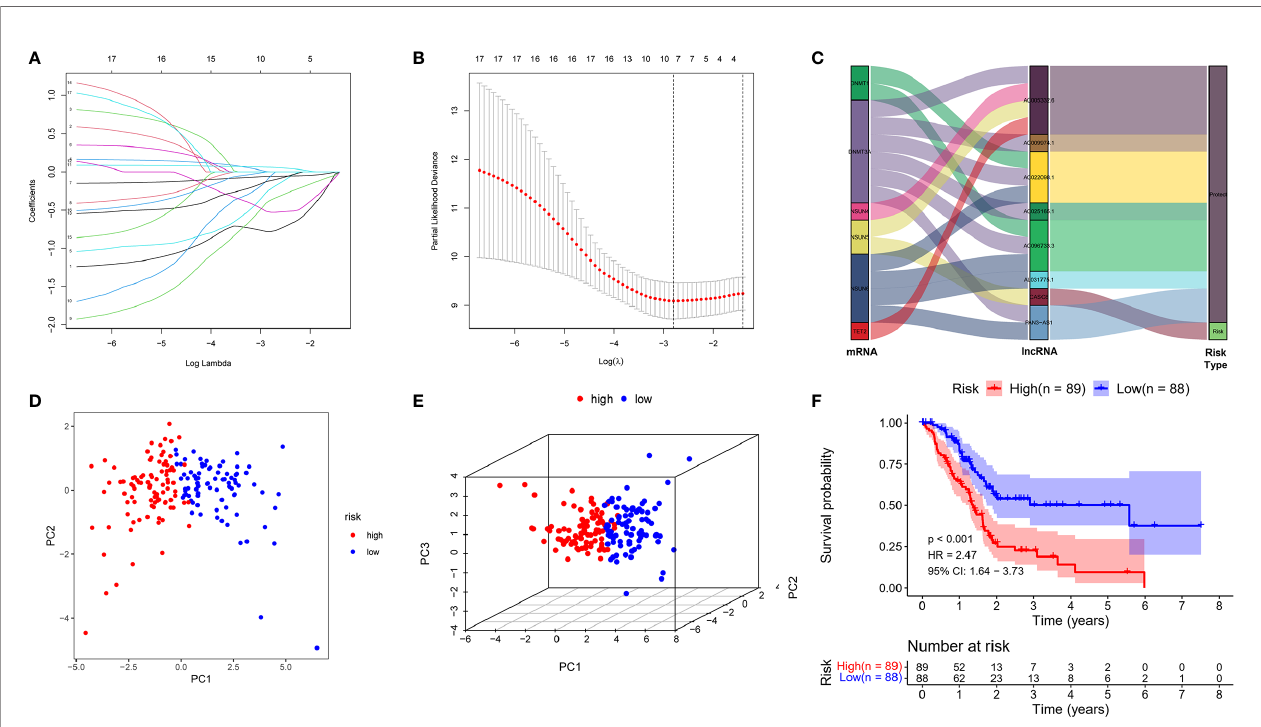
FIGURE 2 | Constructed a m5C-related lncRNA risk model in the PDAC cohort. (A) LASSO regression of the 17 m5C-related lncRNAs. (B) Cross-validation for optimizing the parameter in LASSO regression. (C) The Sankey diagram displayed the relationship between the 6 m5C regulators mRNA expression and the 8 m5C- related lncRNAs. (D, E) PCA and three-dimensional PCA analysis derived from the m5C-related lncRNAs indicated that the patients were divided into two signi fi cantly high- or low-risk distribution patterns. (F) KM curve shows that patients in the m5C-related lncRNA low-risk group survived dramatically longer than those in the high-risk group.